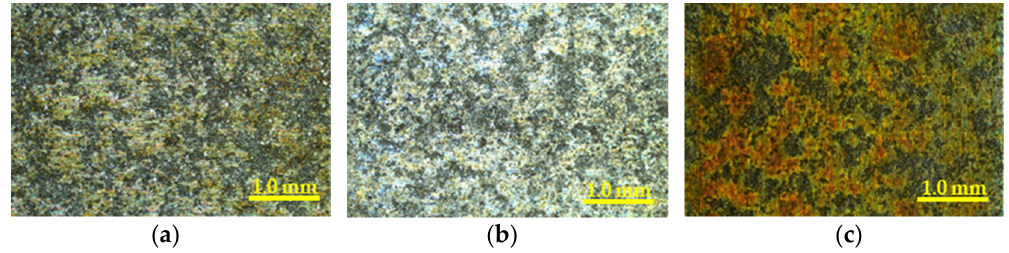
( f ) Figure 9. Comparisons of the results of the traditional method and our intelligent method. ( a–c ) The images before laser cleaning; ( d ) the cleaned image of ( a ) using the traditional laser cleaning method; ( e ) the cleaned image of ( b ) using the intelligent laser cleaning method; ( f ) the cleaned image of ( c ) using the intelligent laser cleaning method. 4. Discussion In recent years, laser-cleaning technology has met the intelligent development trend. More state-of-the-art sensors are considered to collect cleaning state information, and a series of machine-learning algorithms are developed to improve the intelligence degree of the whole cleaning system [26]. In our research, when evaluating the laser-cleaning performance, to use machine vision to replace the human-involved judgment method, a two-stage quantitative evaluation approach is proposed; therefore, the evaluation effect can be close to the subjective understanding of humans. Compared with other methods, our proposed method is more stable in cleaning performance assessment. The PSO-SVM is considered to forecast the laser process parameters. A random process parameter generation method and an iterative computation strategy are designed to search the qualified laser parameters. Similar to the classic Monte Carlo technique [27], our proposed techniques can also find the proper solution with a limited iteration computation. The relationship between the cleaning performance and some specific laser process parameters is also investigated. Power is one of the most important process parameters of laser cleaning. Figure 10 shows some typical results of substrate oxidation after cleaning. Table 6 shows the corresponding laser parameters of Figure 10. In Figure 10, the substrate is oxidized seriously in Figure 10a, and some small rust spots still remain. In Figure 10b, to overcome the oxidation